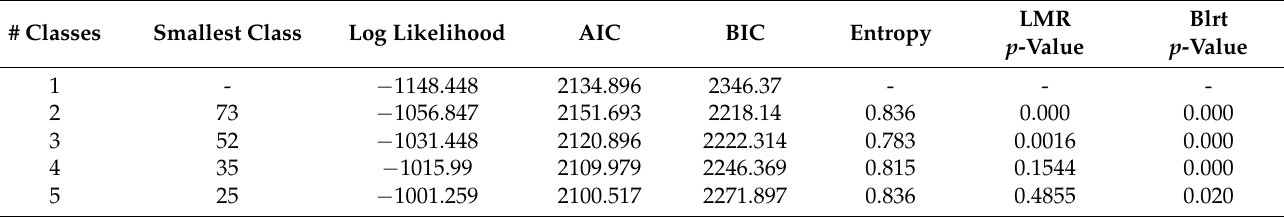
Table 2. Latent class model fit statistics ( n =